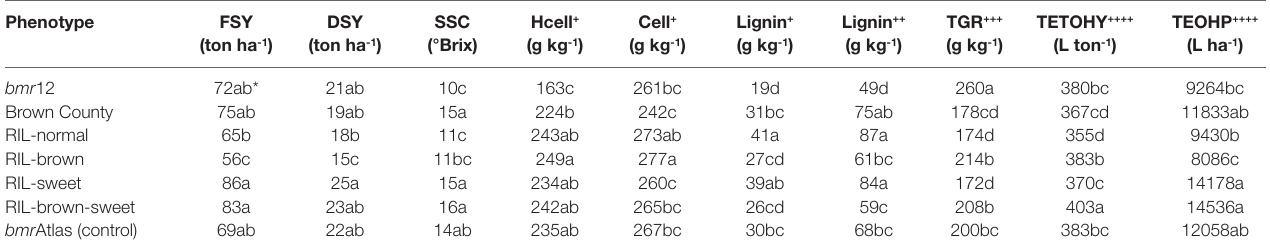
TABLE 3 | Mean agronomic (FSY and DSY), compositional (SSC, hemicellulose, cellulose, and lignin), and theoretical ethanol related traits (TGR, TETOHY, and TETOHP) of parental lines ( bmr12 and Brown County), a commercial control genotype bmr Atlas, and four phenotypic RIL groups.